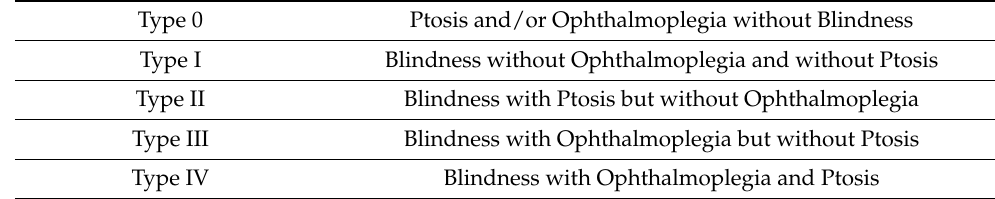
Table 5. Classification of blindness and periocular complications